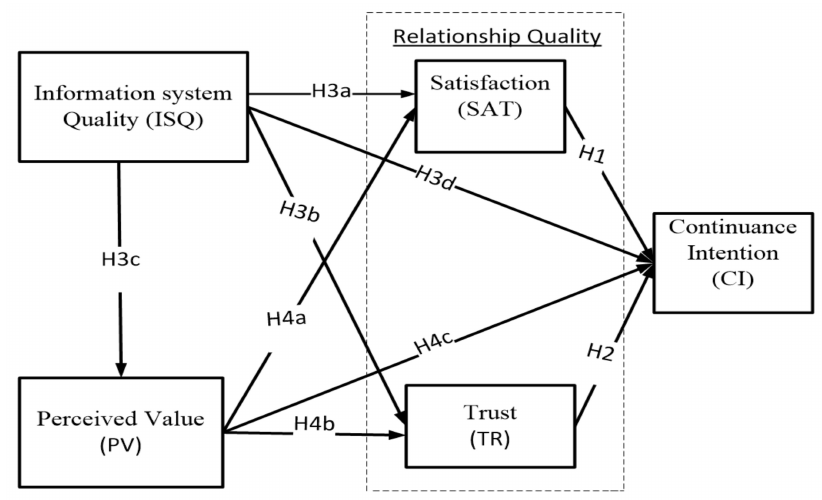
Figure 1. Relationship quality research model. Note: H =